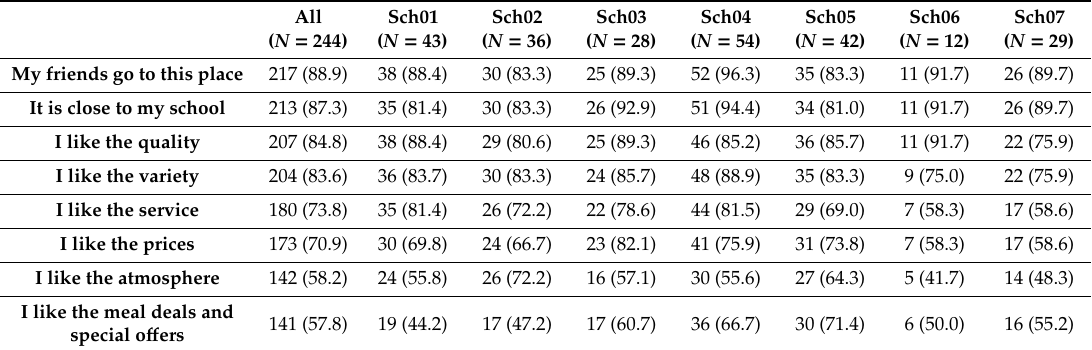
Table 6. Reasons for visiting outlets beyond the school gate on day the Purchasing Recall Questionnaire was